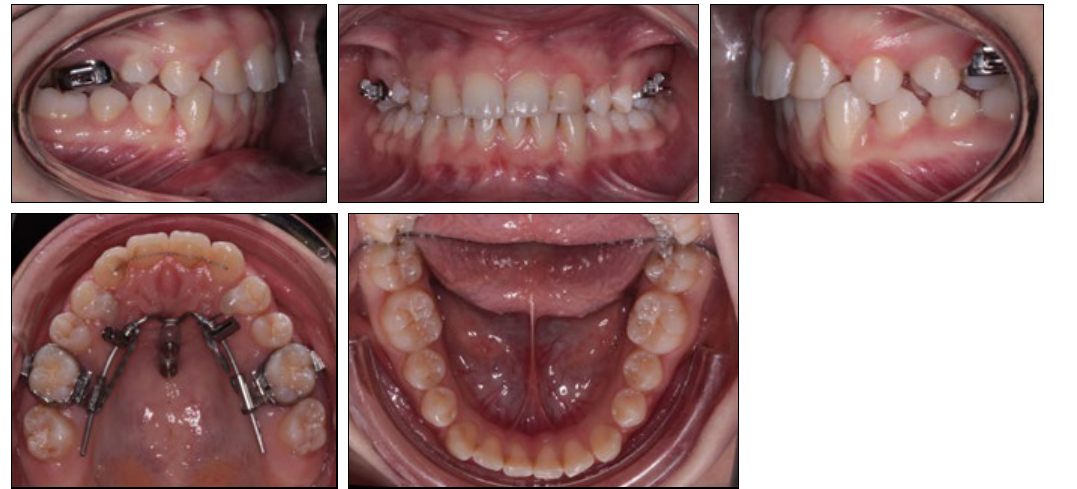
Figure 9. Progress intraoral photographs recorded 17 months into treatment highlighting the excellent mesialisation of all upper premolar and molar